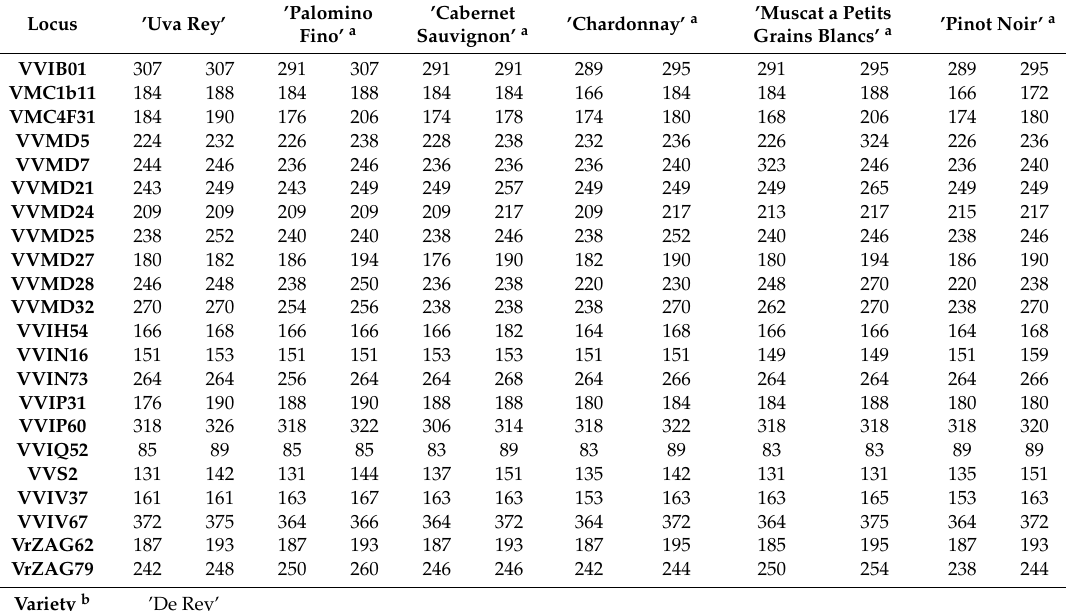
Table 1. Genetic profiles of ’Uva Rey’ and reference cultivars at 22 microsatellite loci. Alleles sizes are given in base